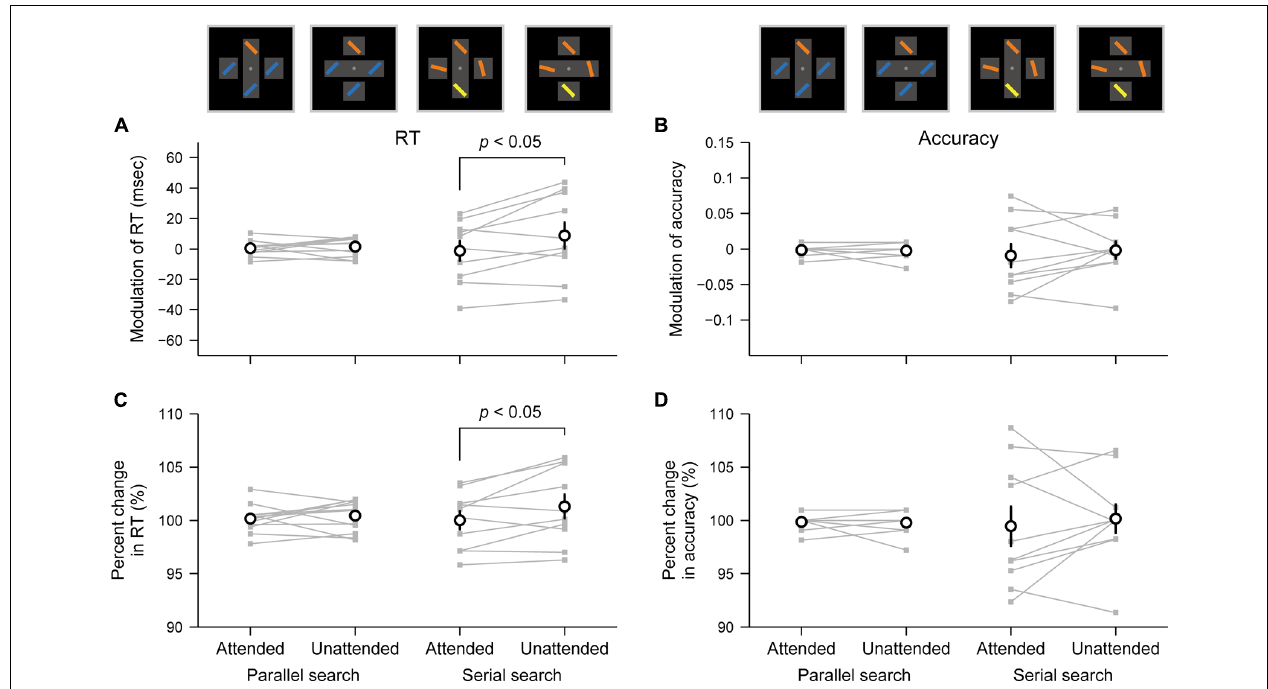
behavioral changes that arose from attention to rectangles. (C,D) Percent changes in RT (C) and accuracy (D) relative to the cross condition in each task. Gray-filled plots connected by thin lines represent each participant’s data. Open circles represent averaged values across participants. Error bars represent SEM.